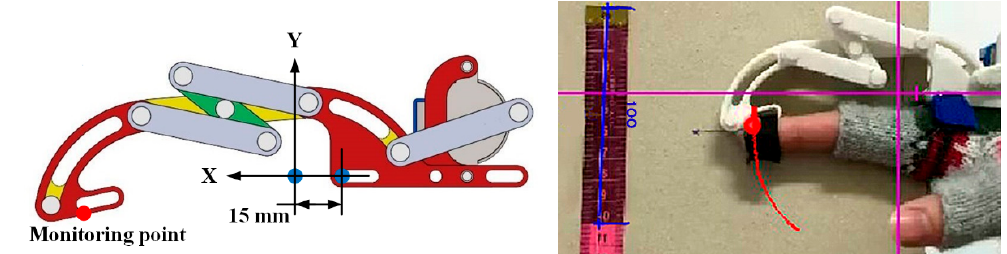
Figure 4. Definition of the monitoring point and original point for the simulation ( left ) and the real displacements of the exoskeleton robot fingertip. The blue line in the photo represents 100 mm, and the red line refers to the trajectory of the fingertip ( right ).